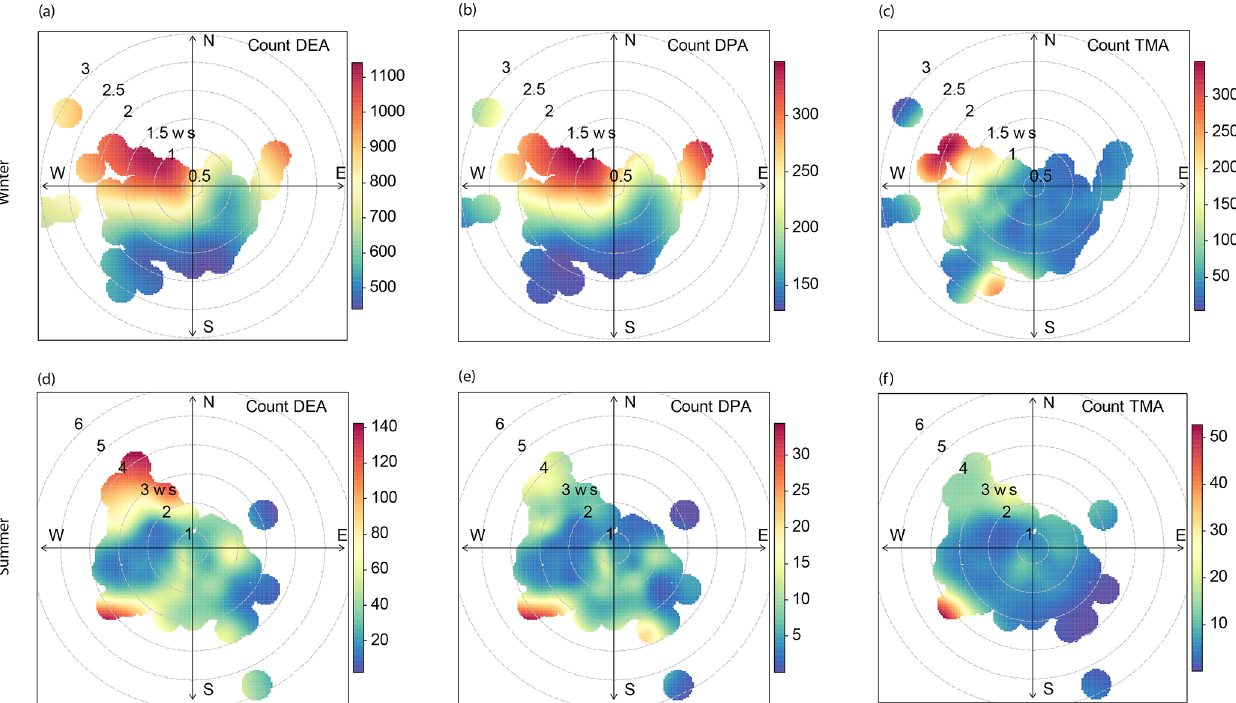
Figure 4. Polar plots of amine-containing particles during winter and summertime. The axes in each figure indicate hourly count of each particle type, and the colors within the circles represent wind speed